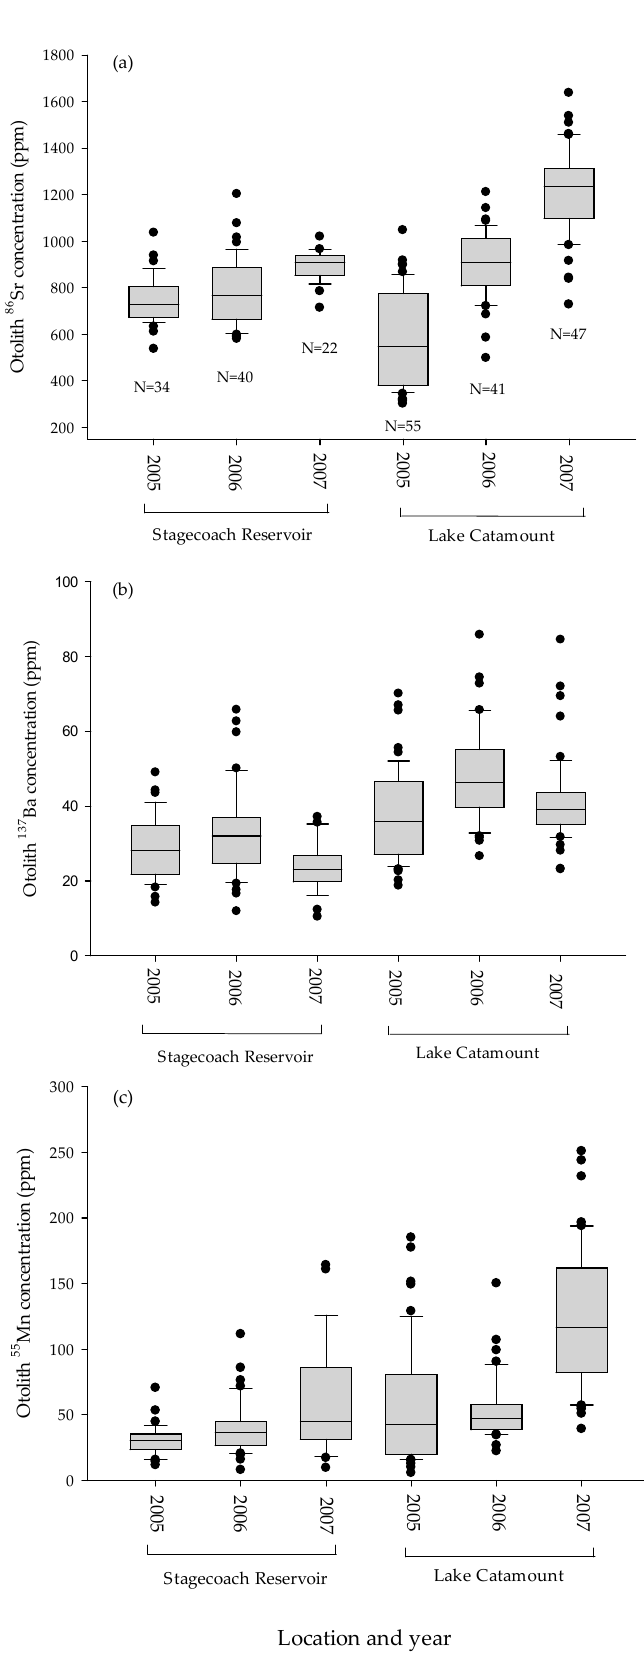
Figure 2. Box plots of northern pike otolith isotopic concentrations (( a ) 86 Sr, ( b ) 137 Ba, and ( c ) 55 Mn) collected from Lake Catamount and Stagecoach Reservoir, Colorado, USA, from 2005–2007.